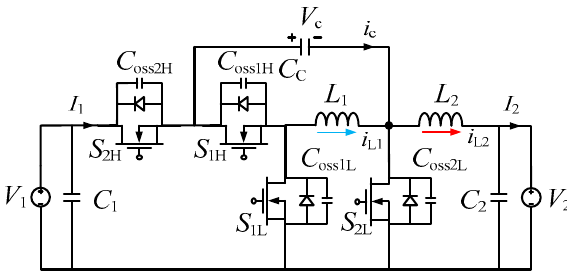
Figure 2. The high-voltage-gain DC–DC converter in TCM operation.